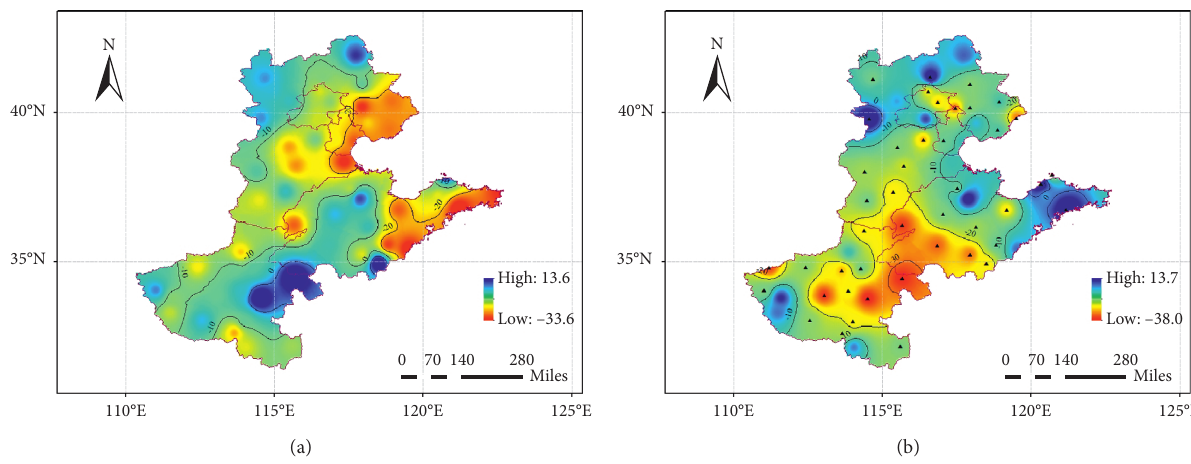
Figure 3: Spatial distribution of precipitation (a) and ET